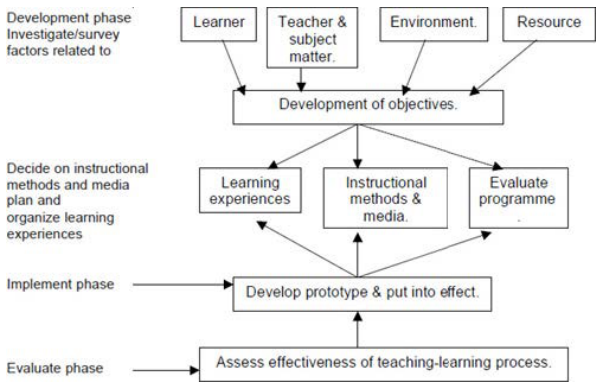
Fig. 3 Flow chart of teaching